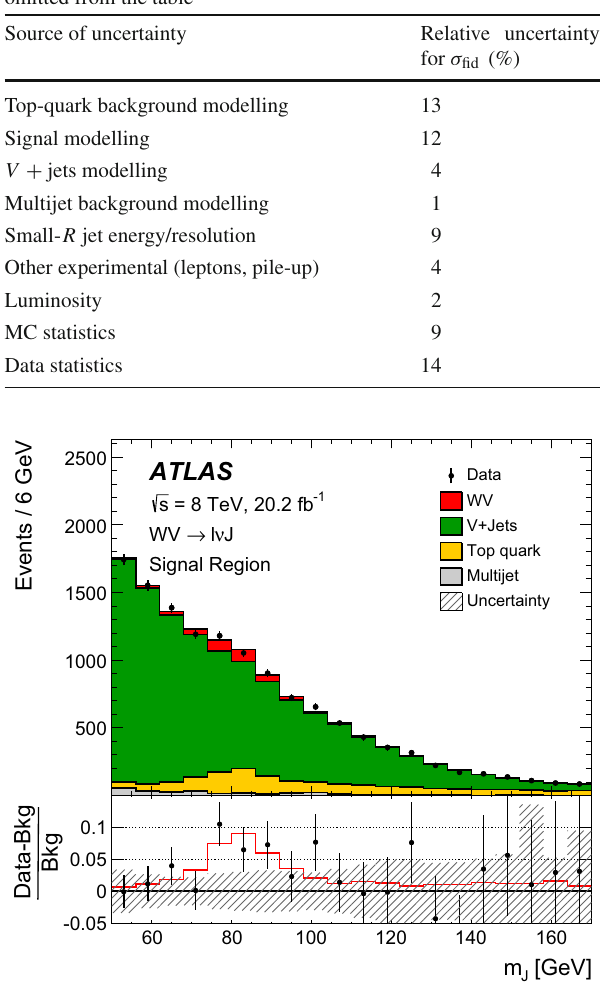
Fig. 5 The observed m J distribution in the WV → (cid:4)ν J signal region, overlaid with the post-fit background and signal estimates. The hatched band indicates the total uncertainty of the fit result